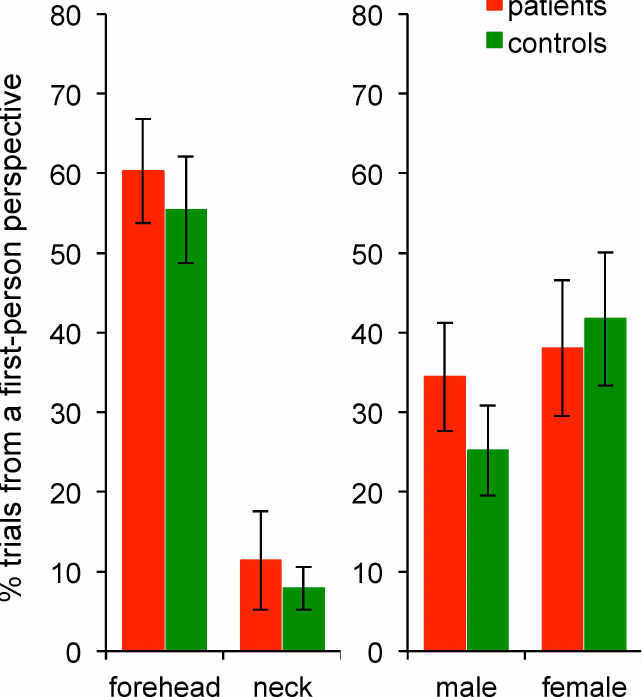
Fig 5. Results from the graphaesthesia task (Experiment 2). Histograms on the left represent the main effect of the within-subject factor Site of stimulationand histograms on the right representthe main effect of the between-subject factor Group. Data from patients and controls are shown separately for illustration purposes only. Histograms representthe mean of the percentageof trials perceivedfrom a first-person perspectiveand vertical bars represent the standard error of the